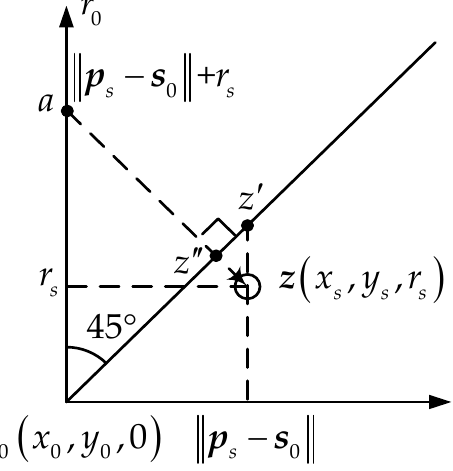
Figure 4. Normal vector longitudinal section.